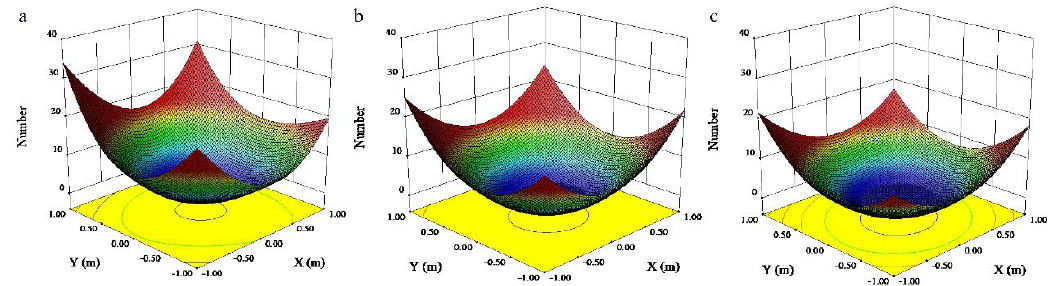
Figure 5. Number of branches in the different layers. The x -axis is the distance in the east (+) and west (−) directions from the trunk. The y -axis shows the distance in the south (+) and north (−) directions from the trunk. The z -axis represents the number of branches. ( a ) Top layer; ( b ) middle layer; ( c ) lower layer.